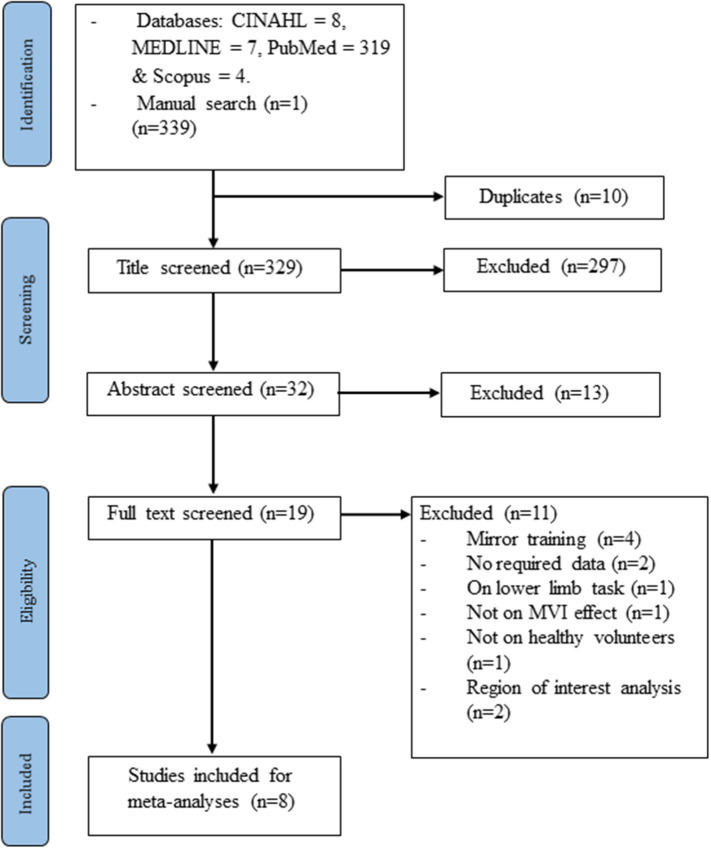
Study flowchart.